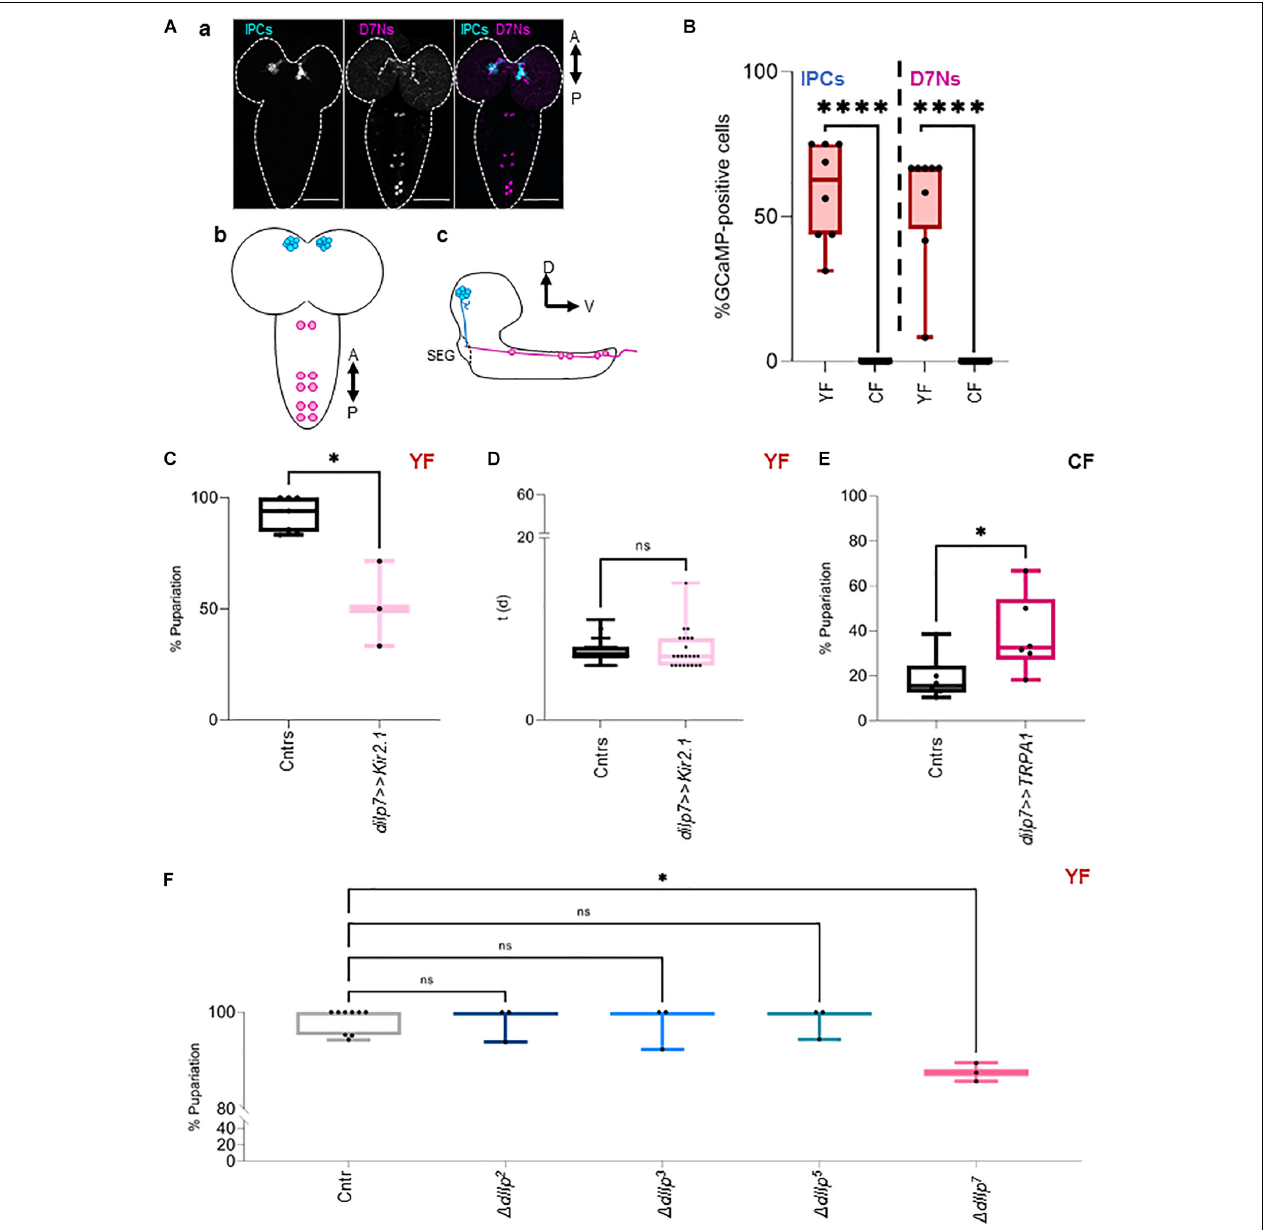
FIGURE 1 | DIlp7-producing neurons provide heat resistance. (A) Confocal Z-projection (a, scale bar = 50 µ m) and graphical depictions (b,c) of larval brains. Shown are the relative position of Insulin-producing cells (IPCs, blue) and dIlp7-neurons (D7Ns, magenta). Crossed arrows point out relative view axis. (B) Fluorescent GCaMP neurons were counted in fixed brains from larvae kept on yeast food (YF, red box-plots) or corn food (CF, black box-plots) at 20 ◦ C. Shown are the percentage of activated cells for n brains (black dots). Significance calculated by Mann-Whitney’s test, p < 0.0001 ∗∗∗∗ . For crude data, see Supporting informations_Raw data_Main figures/ Supplementary Figure 1B (C,D) Plotted are the percentage of formed pupae (C) or the time (in days, d) to reach pupariation (D) of individual larvae kept on yeast food (YF). Compared are genetic controls (Cntrs; pooled data of dilp7-Gal4/+ and UAS-Kir2.1/+ ) and larvae expressing Kir2.1 in D7Ns ( dilp7 > > Kir2.1 , light-pink) at 28 ◦ C. (C) Box plot, each black dot represents one experiment with minimum n = 6 individual larvae. Significance calculated by Mann-Whitney’s test, p = 0.0167 ∗ . For crude data, see Supporting informations_Raw data_Main figures/ Supplementary Figure 1C . (D) Box-plot, each black dot represents one larva. Significance calculated by Kruskal-Wallis test, p = 0.7457 ns . For crude data, see Supporting informations_Raw data_Main figures/ Supplementary Figure 1D . (E) Plotted are the percentage of formed pupae of genetic controls (Cntrs; pooled data of dilp7-Gal4/+ and UAS-TRPA1/+ ) and larvae expressing TRPA1 in D7Ns ( dilp7 > > TRPA1 , dark-pink) kept on corn food (CF) at 28 ◦ C. Box-plot, each black dot represents one experiment with minimum n = 6 individual larvae. Significance calculated by Mann-Whitney’s test, p = 0.0411 ∗ . For crude data, see Supporting informations_Raw data_Main figures/ Supplementary Figure 1E . (F) Shown is the developmental success on yeast food (YF) at 28 ◦ C. Plotted are the percentage of formed pupae of genetic controls ( mCherry:FOXO , Cntr) and different dIlp mutants as indicated on the X -axis. Box plot, each dot represents one experiment with minimum n = 6 individual larvae. Statistics, Kruskal-Wallis test, p > 0.9999 ns ; p = 0.0141 ∗ . For crude data, see Supporting informations_Raw data_Main figures/ Supplementary Figure 1F .